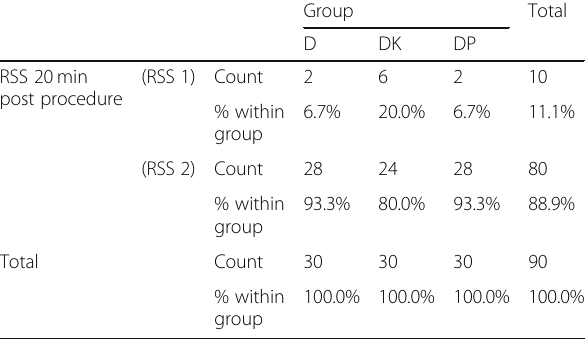
Table 10 Ramsay sedation score 20 min post